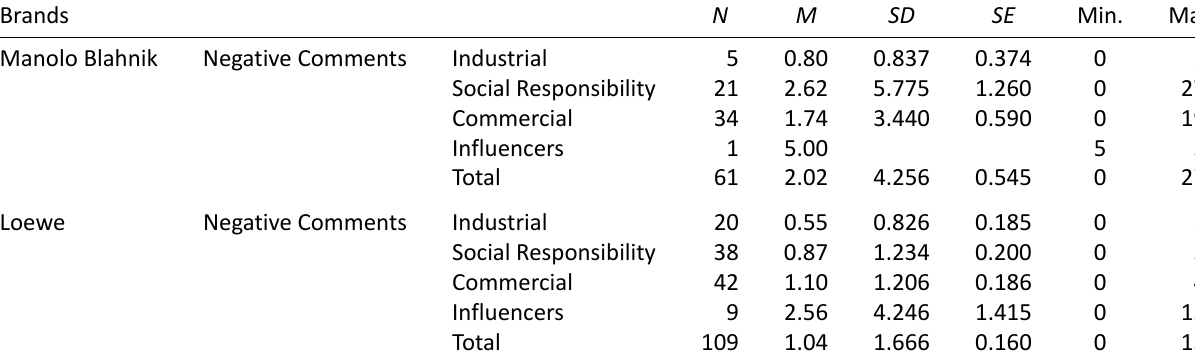
Table 8. Descriptive statistics of the negative comments generated according to brand content. Brands